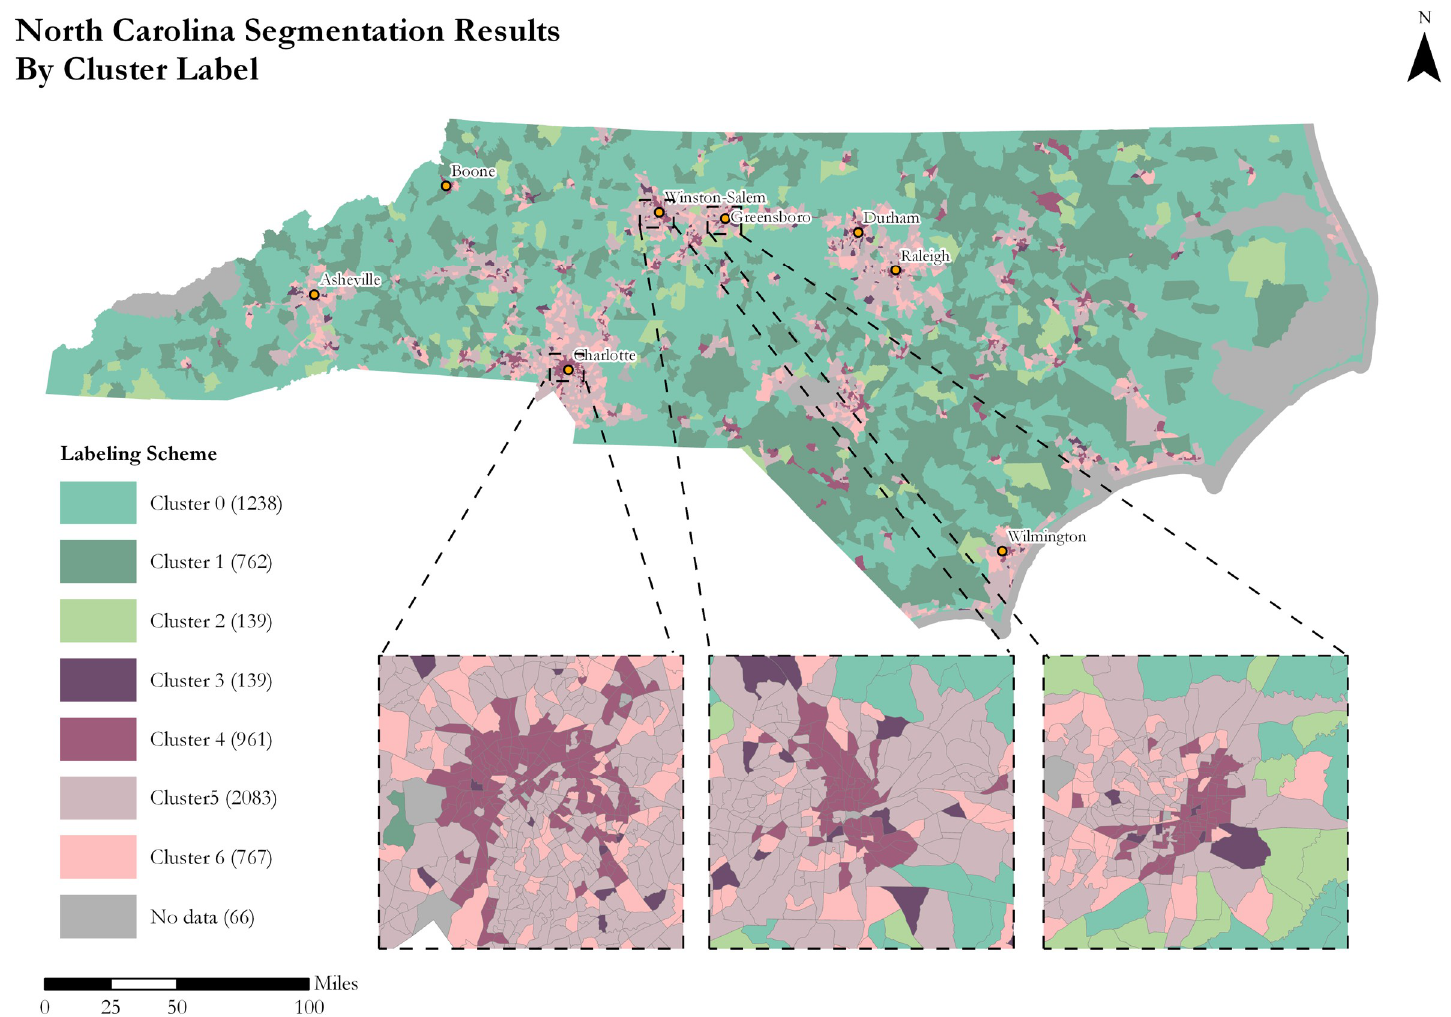
Figure 7. Spatial distribution of food access groups in North Carolina.